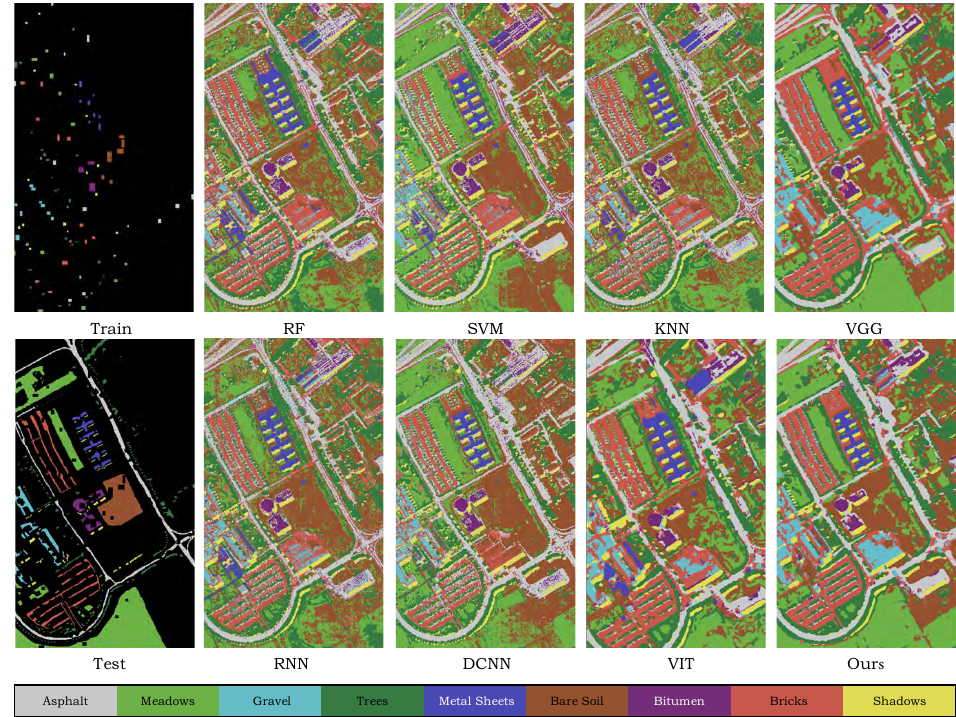
Figure 8. Visualization of the results of different algorithms on Pavia University